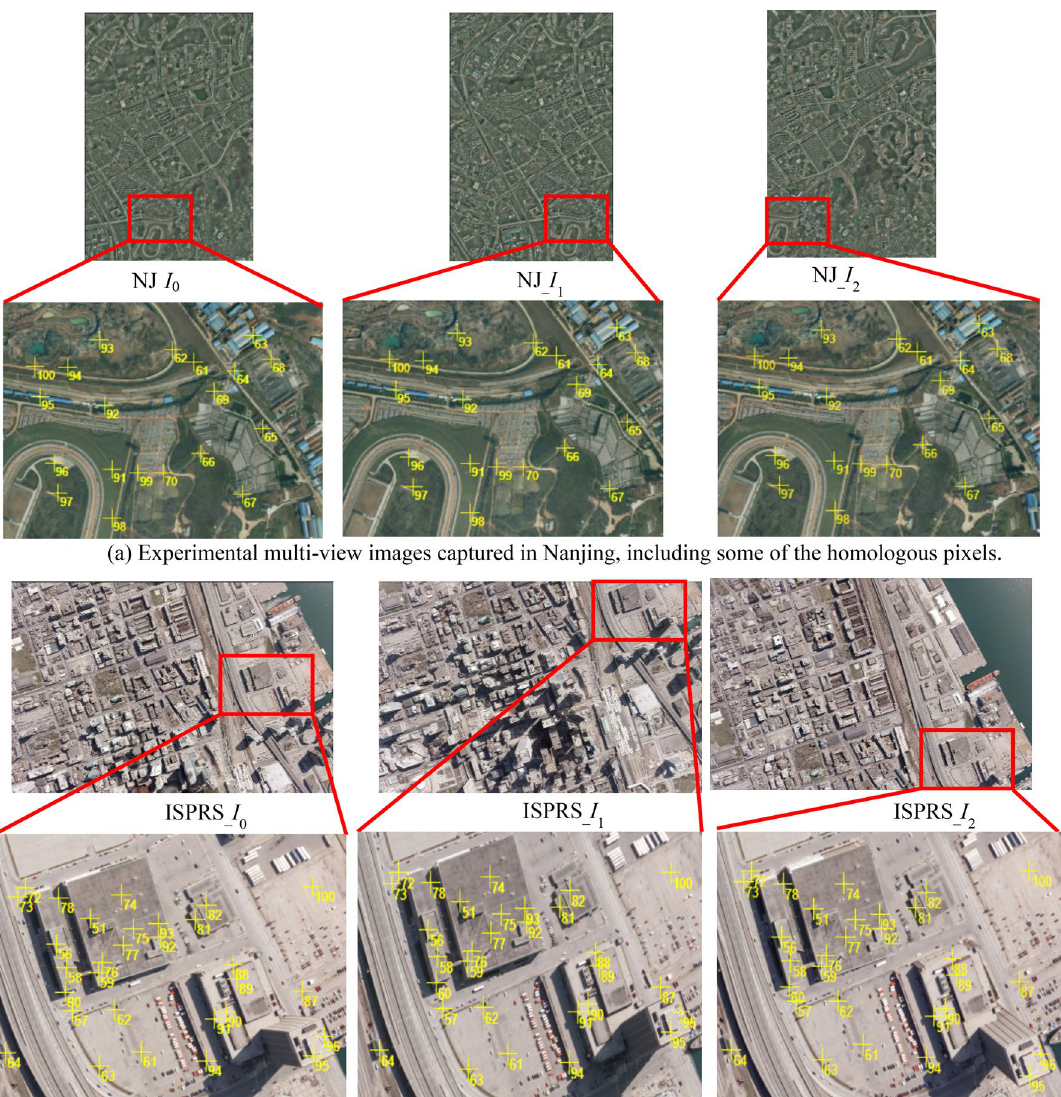
Figure 6. Two types of experimental aerial images (Images in sub-figure ( a ) were captured by our partner Jiangsu Digitalland Technology Corporation, Ltd., Co. with an UltraCam metric digital camera in Nanjing China in November 2011, and images in sub-figure ( b ) are internationally public benchmark data in Toronto Canada provided by ISPRS Working Group III/4: http:// www2. isprs. org/ commi ssions/ comm3/